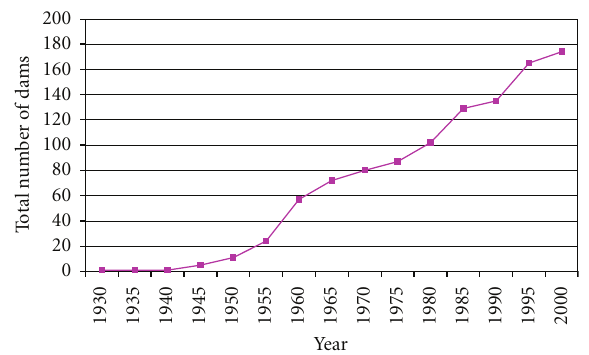
Figure 1: Cumulative number of small dams in Zimbabwe (1930– 2000) Adapted from Senzanje and Chimbari (2002). Inventory of small dams in Africa: A case study for